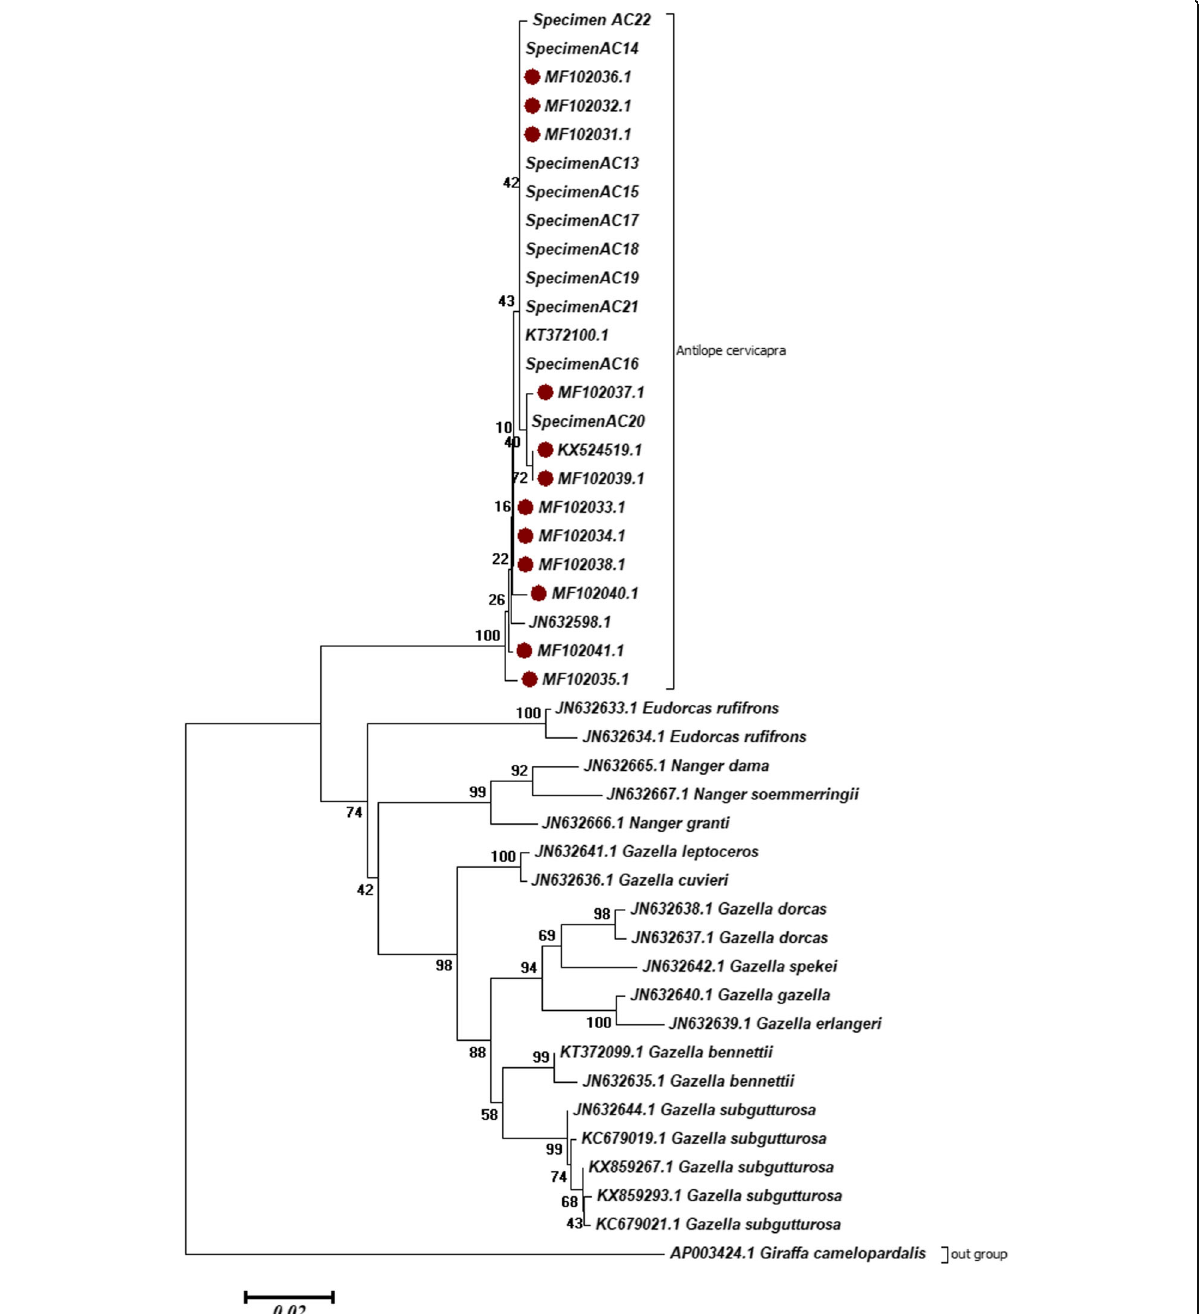
Fig. 1 NJ-Phylogenetic tree (K2P) inferred from 636 base-pair 43 partial COI sequences for 13 species belonging to 4 genus of Antilopinae sub-family. Bootstrap values are shown above the species nodes and for higher taxonomic node. Giraffa camelopardalis was used as an out-group animal to root the phylogenetic